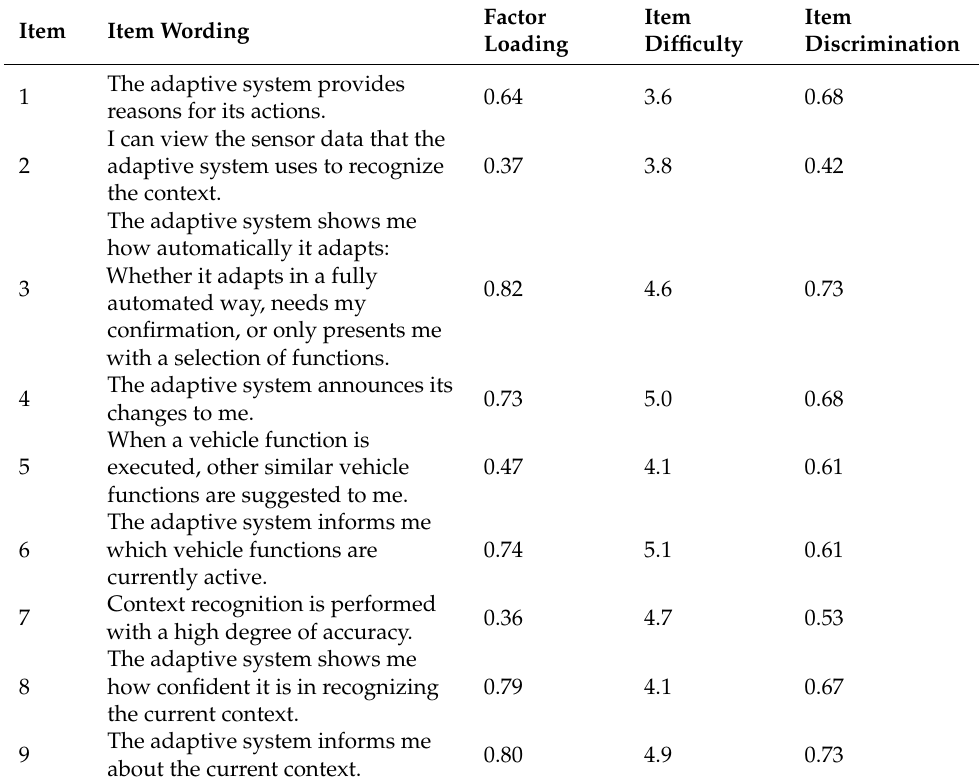
Table A1. Items of Factor 1 “System State and Transparency”.